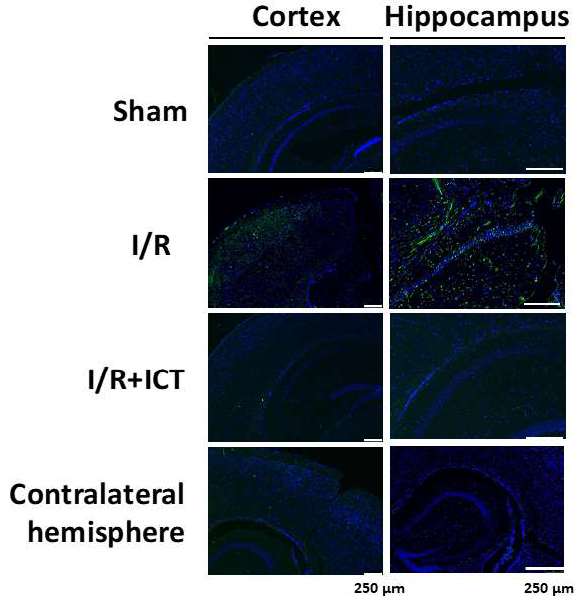
Figure 3. Effects of ICT treatment on neuronal cell apoptosis in the left cerebral hemisphere of mice with acute cerebral ischemia-reperfusion. TUNEL staining was used to detect neuronal apoptotic cells in the hippocampus and cortex. TUNEL-positive cells were stained a fluorescent green color, whereas cell nuclei were stained a fluorescent blue color. Scale bar = 75 μm.